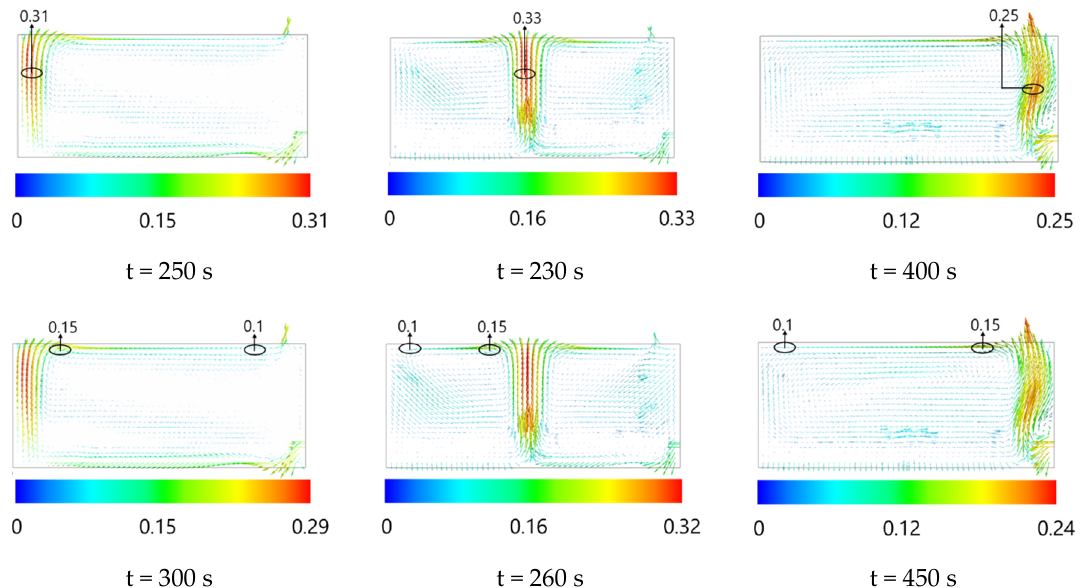
Figure 3. Velocity vectors for Model 1 (left), Model 2 (middle), and Model 3 (right) whilst the envelope of 4% mole fraction of hydrogen was rising to the ceiling (up) and filling the whole ceiling (down) (m/s).